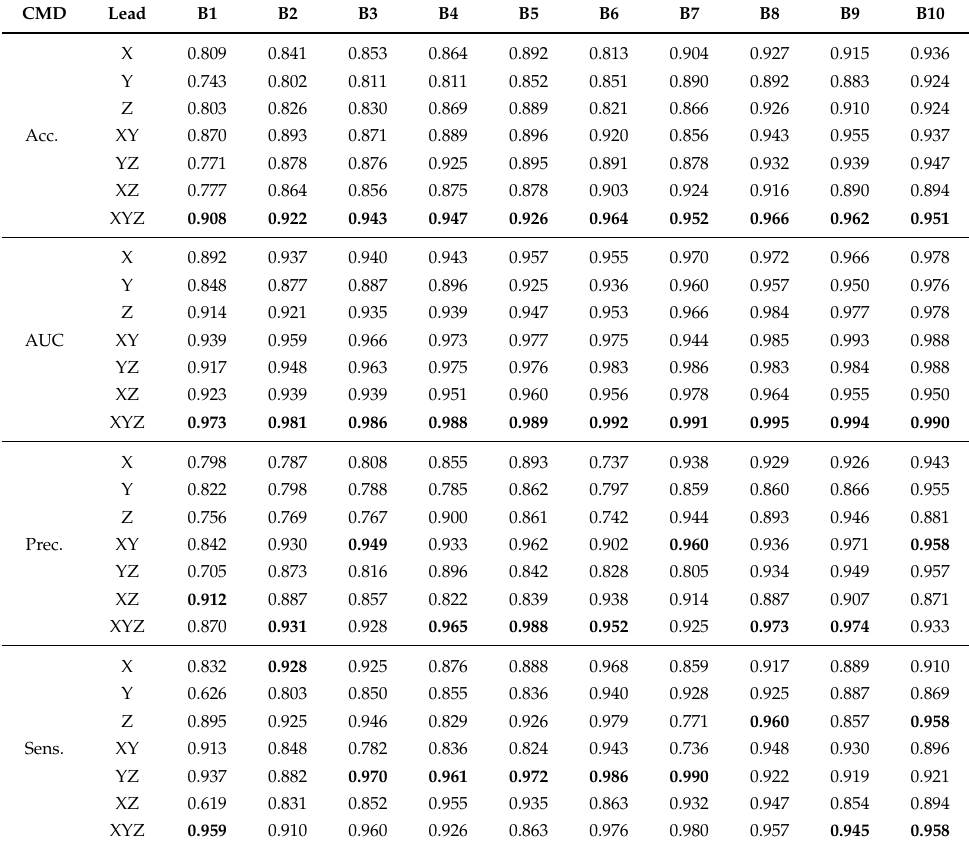
Table 2. Experiment classification metrics. (Maximum values per item are in